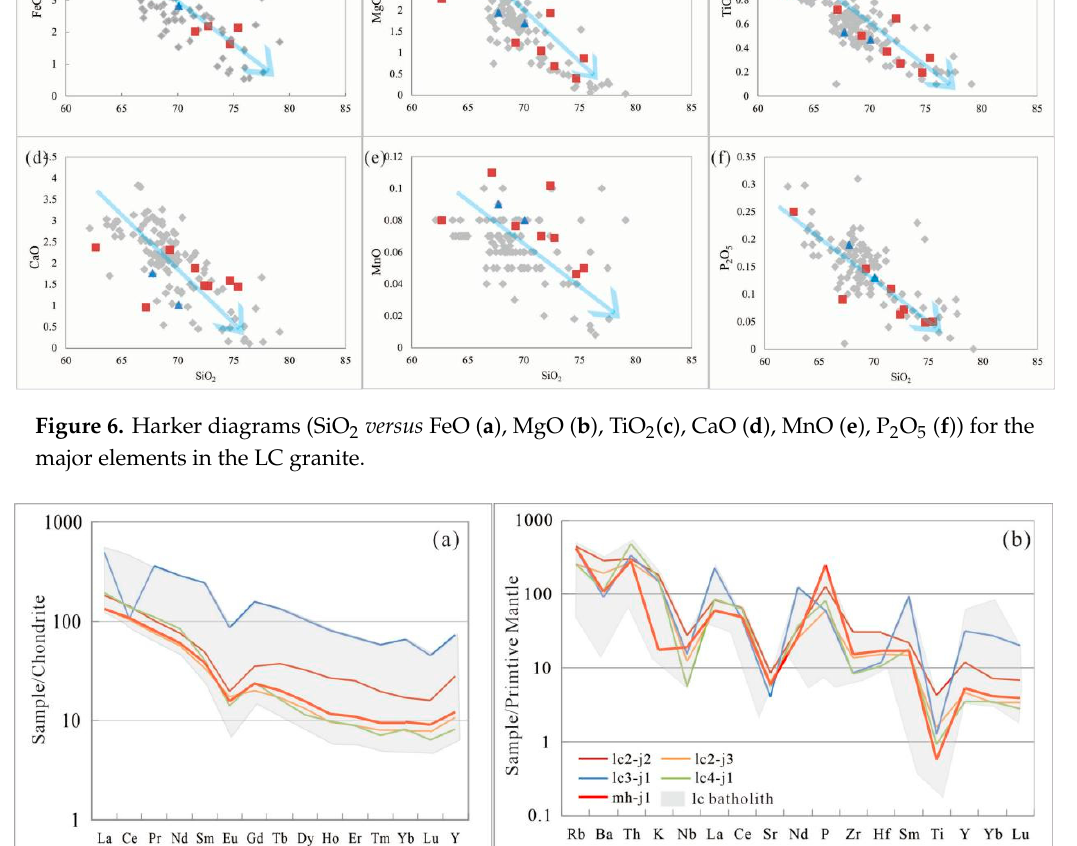
Figure 7. Chondrite-normalized REE patterns ( a ), primitive mantle-normalized elements diagrams ( b ) of the LC granite (normalization values after [47]; the LC batholith data after, e.g.,